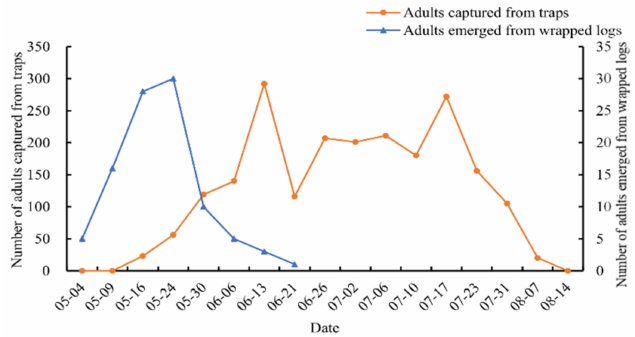
Figure 5. Relationship between the number of M. saltuarius adults captured per week and the number of M. saltuarius emerged per week in 2020. The numbers on the curves indicate the sampling date (month-day).